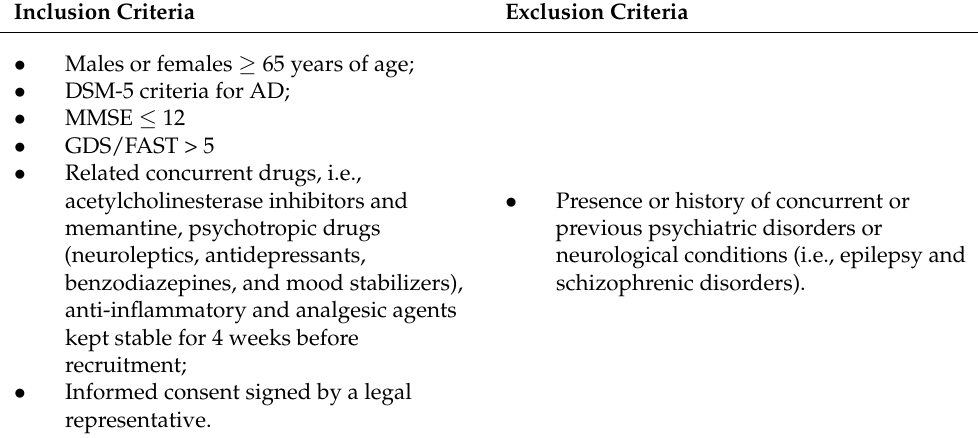
Table 3. Inclusion/exclusion